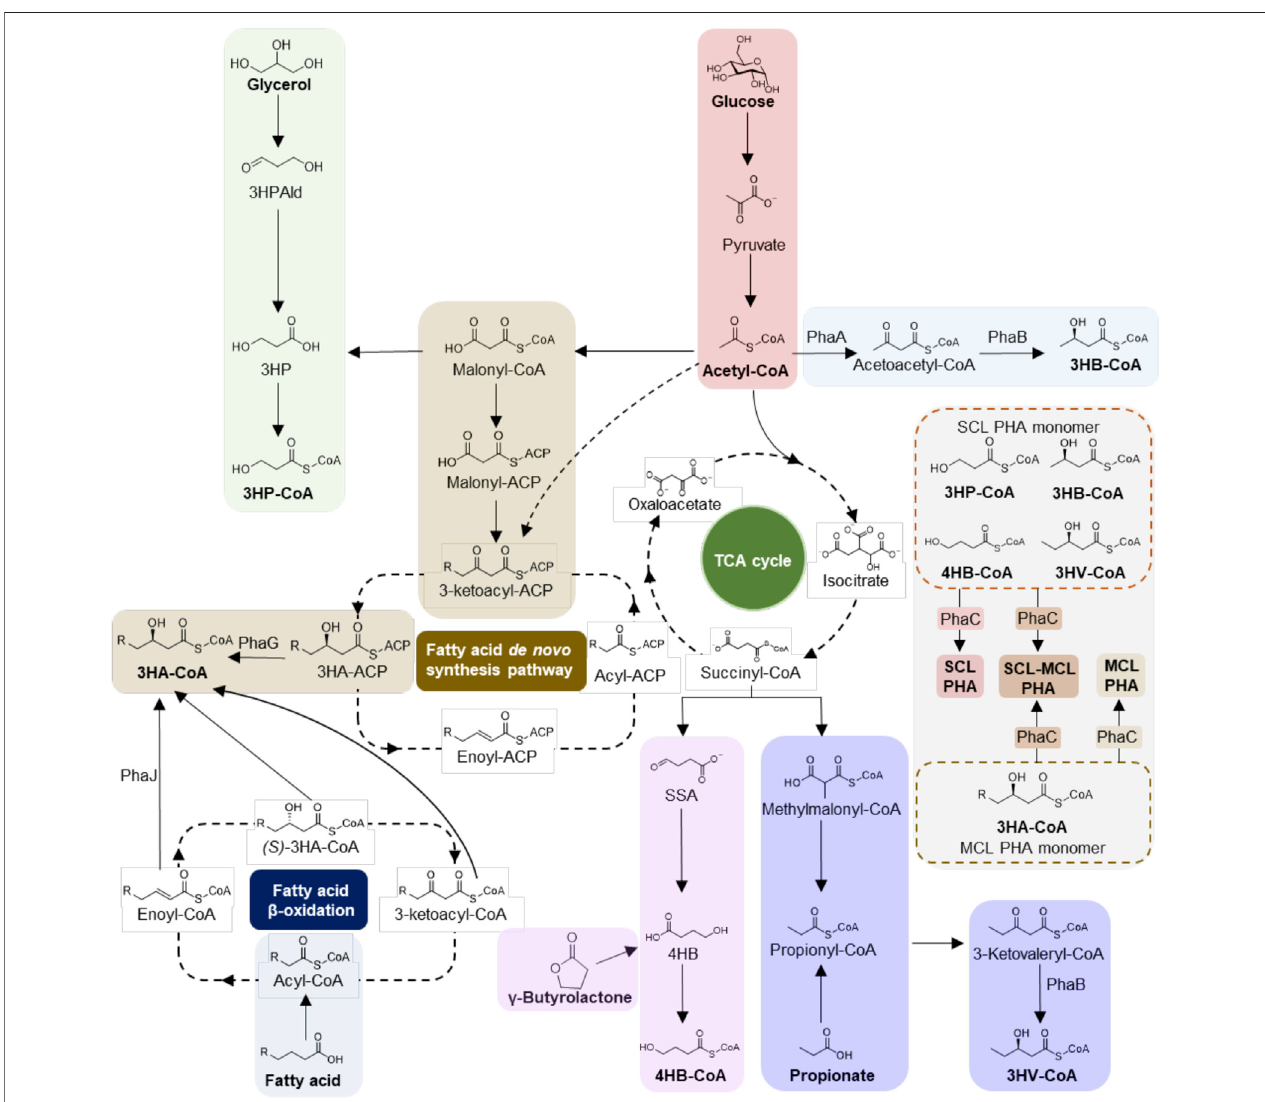
FIGURE 2 | Biosynthesis pathways of SCL- and M/LCL-PHA. Metabolic pathways of short-chain length (SCL) PHA, medium/long-chain length (M/LCL) PHA and theircopolymers(SCL-M/LCL)PHA aresummarized.Speci fi cally,SCLPHAindicatesmonomerscontainingonly3-5carbonatoms(C3-C5),andmonomerswithover6 carbonatomsaretermedM/LCLPHA.Theenzymesandmetabolitesshownare:PhaA, β -ketothiolase;PhaB,acetoacetyl-CoAreductase;PhaC,PHAsynthase;PhaG, 3-hydroxyacyl-ACP-CoA transacylase; PhaJ, enoyl-CoA hydratase; 3HPAld, 3-hydroxypropionaldehyde; 3HP, 3-hydroxyproiponate; 3HA-ACP, 3-hydroxyacyl- ACP; SSA, succinate semialdehyde; 4HB, 4-hydroxybutyrate; 3HB-CoA, 3-hydroxybutyrate-CoA; 3HV-CoA, 3-hydroxyvaleryl-CoA.